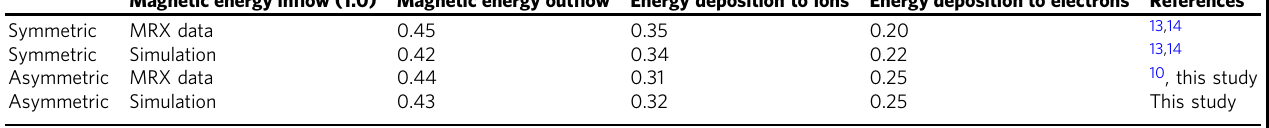
Energy partition measured in MRX for symmetric and asymmetric reconnection is compared with our 2D simulation results. Typical errors of MRX data in this table is about 10%